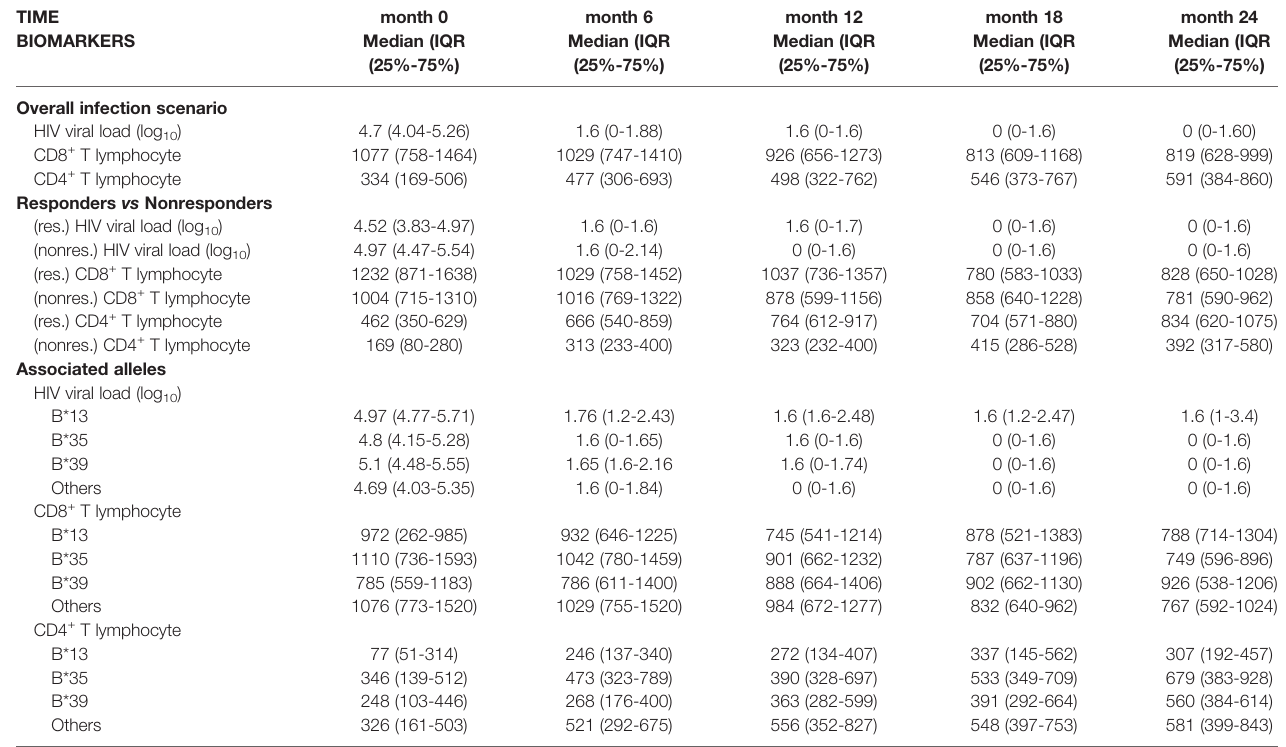
TABLE 1 | Analysis of HIV viral load (log10), CD4+ T lymphocyte count and CD8+ T lymphocyte count over the study